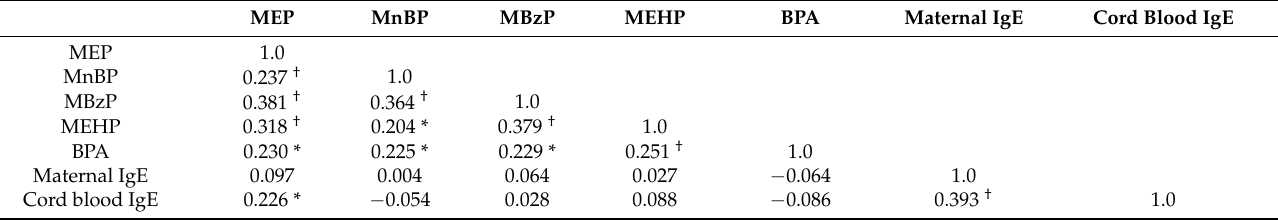
Figure 1. Correlation of cord blood IgE levels with the corresponding maternal IgE and maternal urine monoethyl phthalate (MEP) levels. One hundred and one pairs of maternal plasma and urine samples collected at 24 to 28 weeks of gestation and cord blood samples of their neonates at birth were collected. The correlation of ( A ) cord blood IgE with corresponding maternal IgE and ( B ) maternal urine MEP are shown. Table 4. Spearman correlation among maternal urinary phthalate metabolites, maternal total IgE, and cord blood IgE levels. MEP MnBP